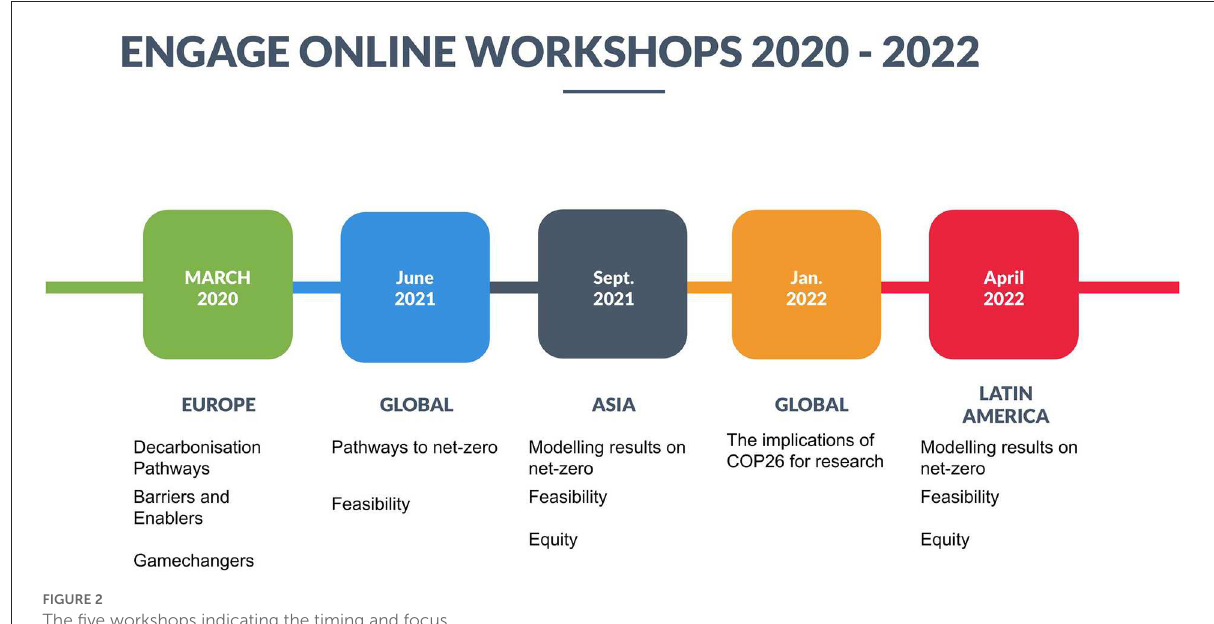
FIGURE2 The five workshops indicating the timing and focus.